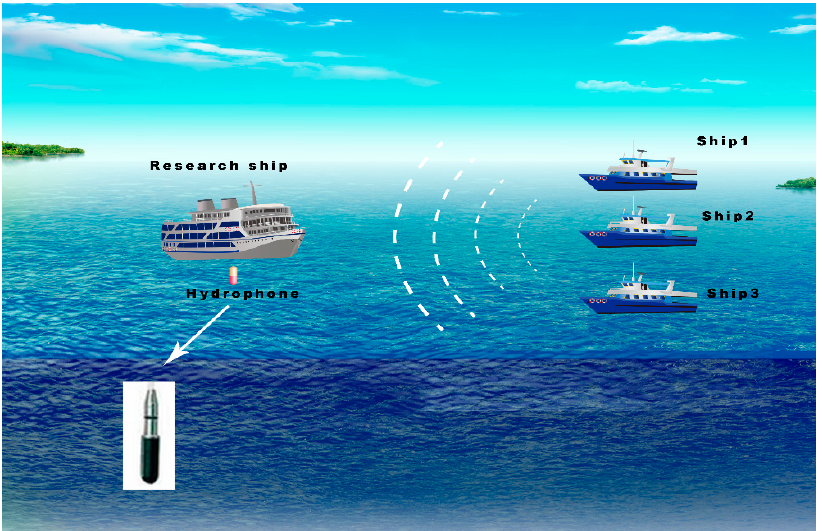
Figure 9. 3D underwater acoustic signal measurement.